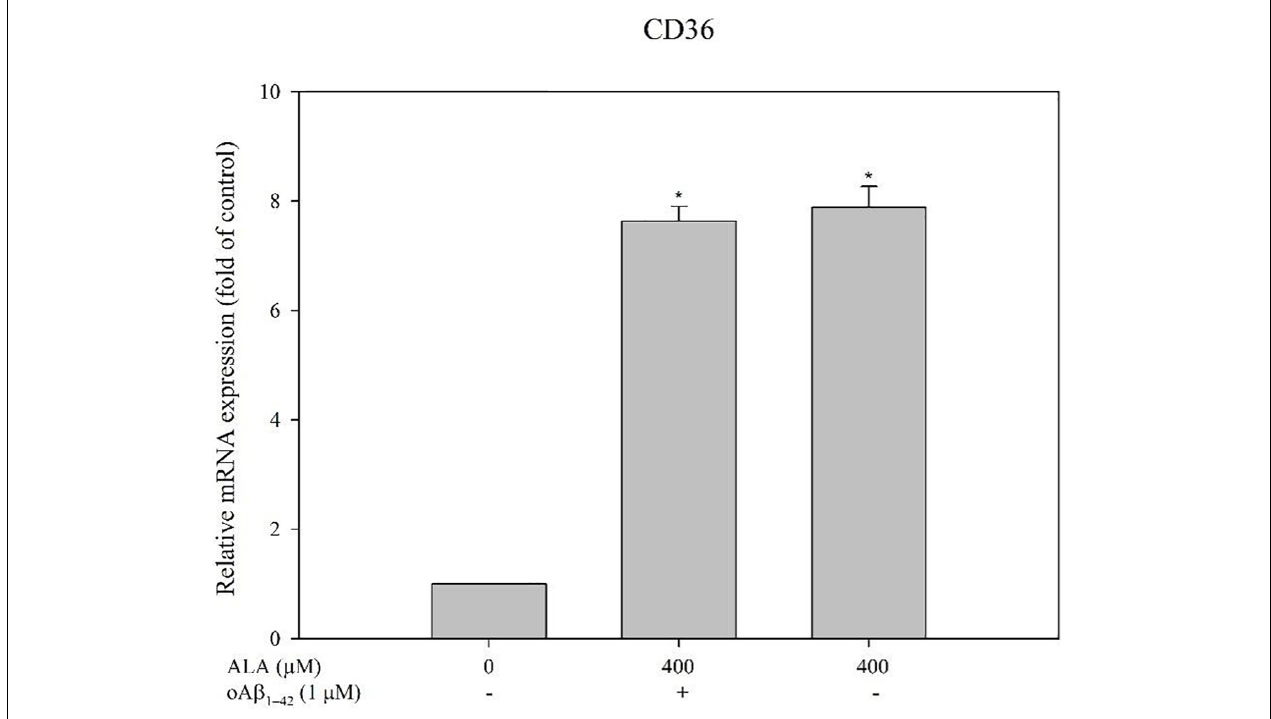
FIGURE 4 | Alpha-lipoic acid elevated CD36 mRNA expression in BV-2 mouse microglial cells. BV-2 cells were pretreated with or without ALA (400 µ M) for 30 min, followed by vehicle or oA β 1 − 42 treatment for 24 h. The relative mRNA expression of CD36 was detected using real-time PCR. * p < 0.05 vs. the control group.